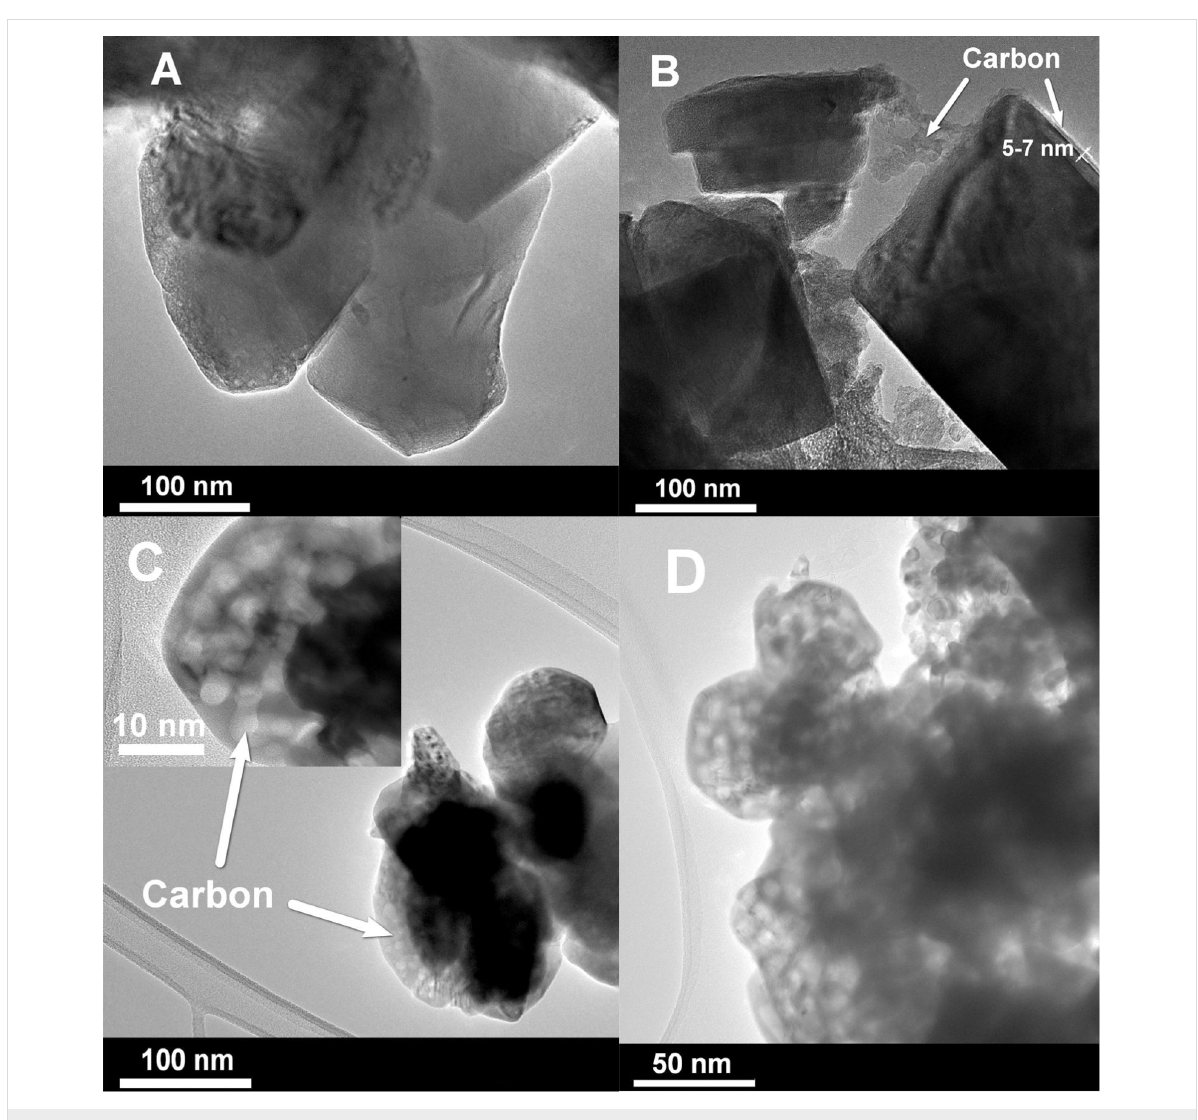
Figure 1: TEM micrographs: A) pure LNM; B) LNM + carbon (linear PVA); C) LNM + carbon (cross-linked PVA); D) carbon, obtained by the isothermal heat treatment of cross-linked PVA at 350 ° С for 15 min in argon.